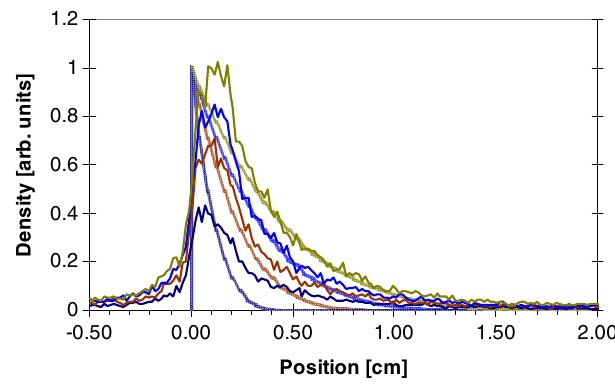
FIG. 14. (Color) Experimental profile of light intensity of gas cloud at 1 (cid:1) s intervals during the beam pulse; density profile gas at 20 (cid:4) C . The smooth from 1D gas cloud model for H 2 shaded curves represent the model